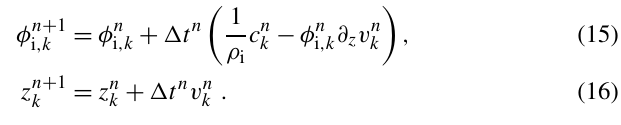
(cid:54)= (cid:49)z n and k k